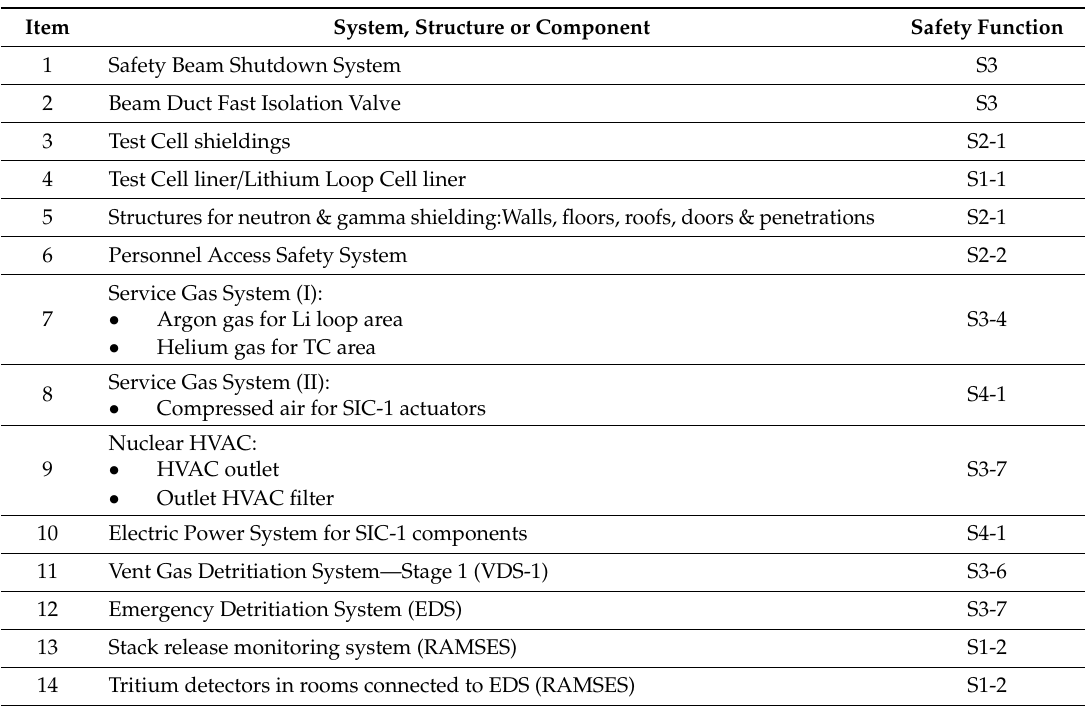
Table 5. Provisional list of SIC-1 SSC. (Safety Functions mentioned in the table are coherent with Table